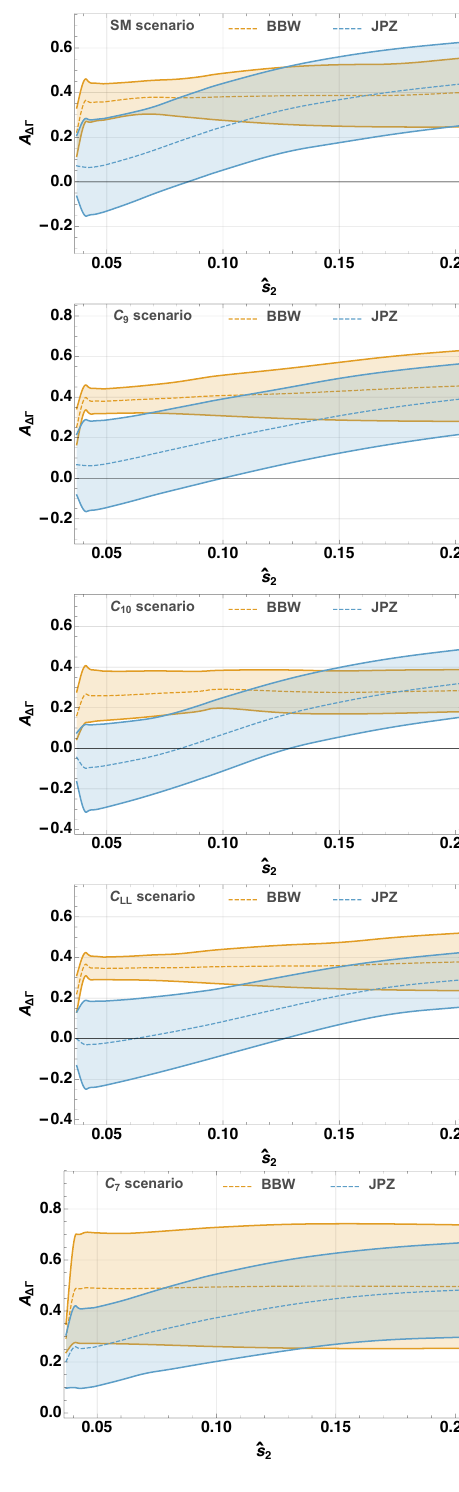
, s 1 ] (left panels) or [ s 2 , 6 GeV 2 ] (right µ